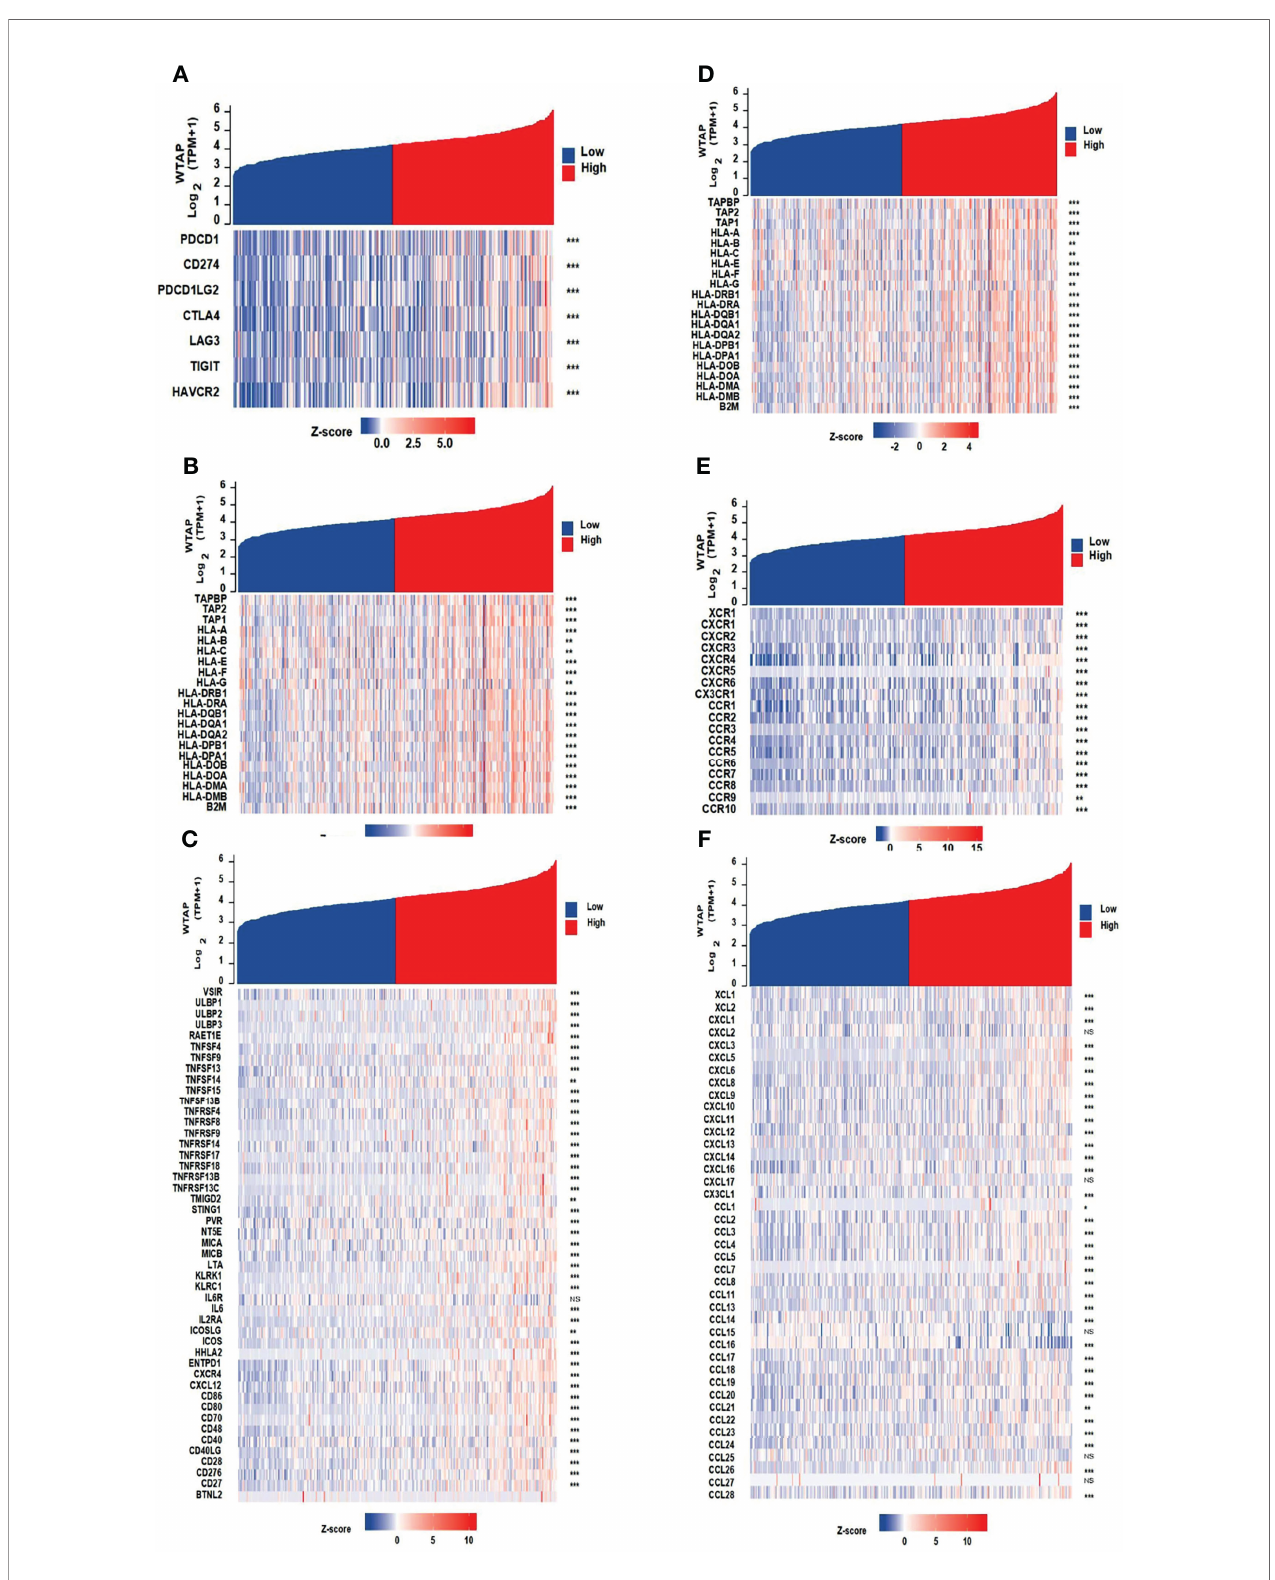
FIGURE 6 | Co-expression of WTAP and immune-related genes, including immune checkpoint genes (A) , immunosuppressive genes (B) , immune activation genes (C) , MHC genes (D) , chemokines receptor genes (E) , and chemokines genes (F)